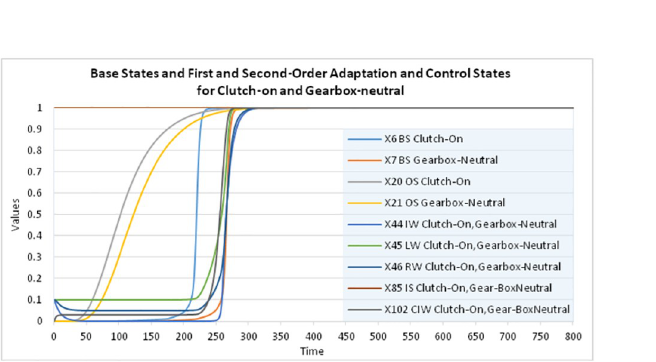
Fig 5. Base states X 6 (Clutch-on) and X 7 (Gearbox-neutral) with impact from OS-states X 20 , X 21 and LW-state X 45 , RW-state X 46 and learner IW-state X 44 and instructor IS-state X 85 with control by CIW-state X 102